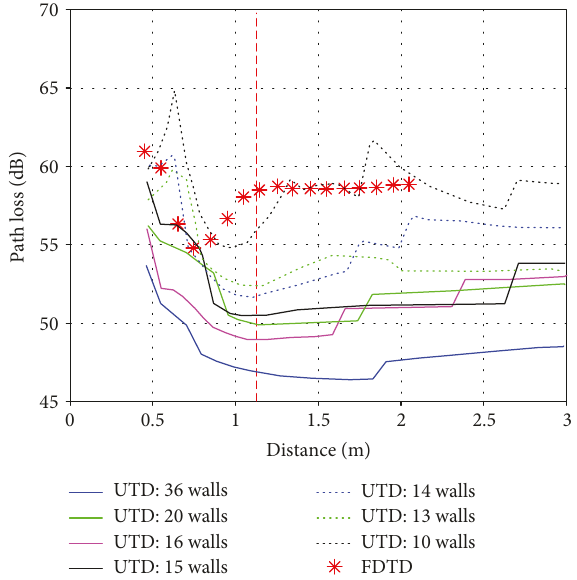
Figure 12: Path loss results obtained using XGtd (UTD method) and XFdtd (FDTD method) for body orientation 2 and for di ff erent numbers of side walls in the UTD